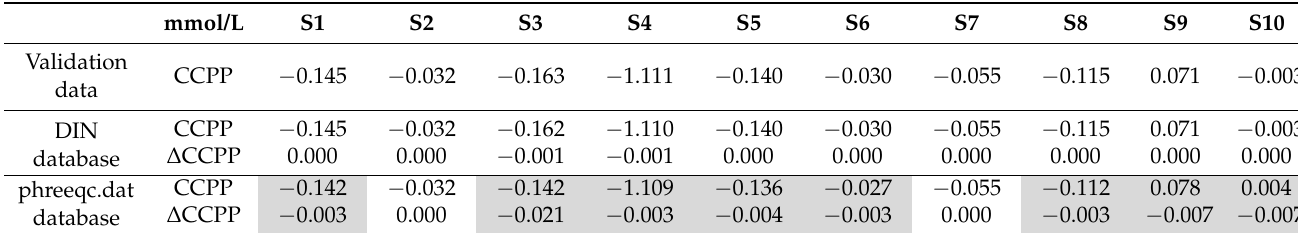
Table 4. CCPP calculated for the 10 validation datasets from the DIN 38404-10 standard with the din38404-10_2012.dat database developed by de Moel et al. (2013) and with the phreeqc.dat database [4,19]. Density of water was assumed 1.00 kg/L Grey shaded cells are not in compliance with the